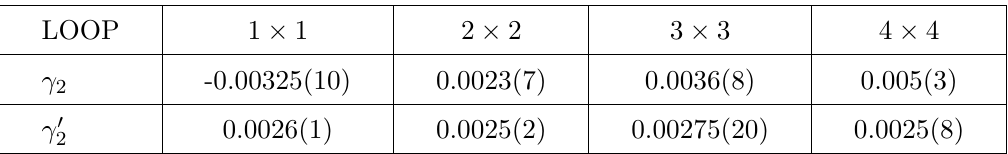
Table 2. Values of the parameters (cid:13) 2 and (cid:13) 0 given by eq.